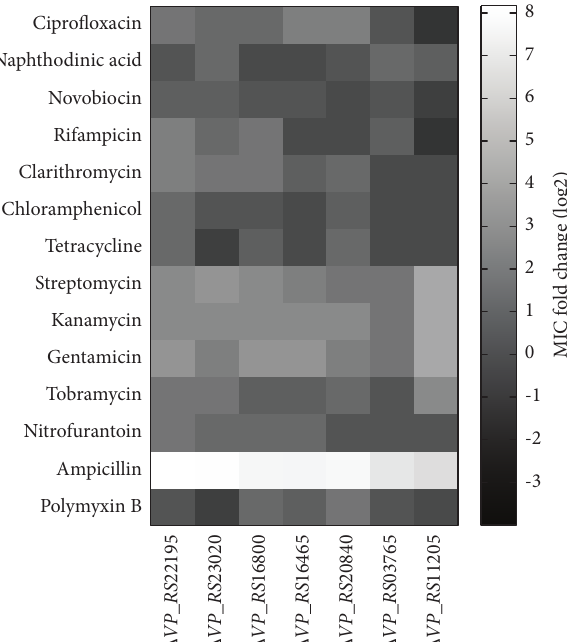
Figure 4: Comparison of resistance to 14 antibiotics among the 7 V. parahaemolyticus OMP deletion mutants, using wild-type ATCC33846 as a control. Te fold change is calculated by log 2 (the MIC of mutants/MIC of ATCC33846). Each color block represents the mean value of three biological